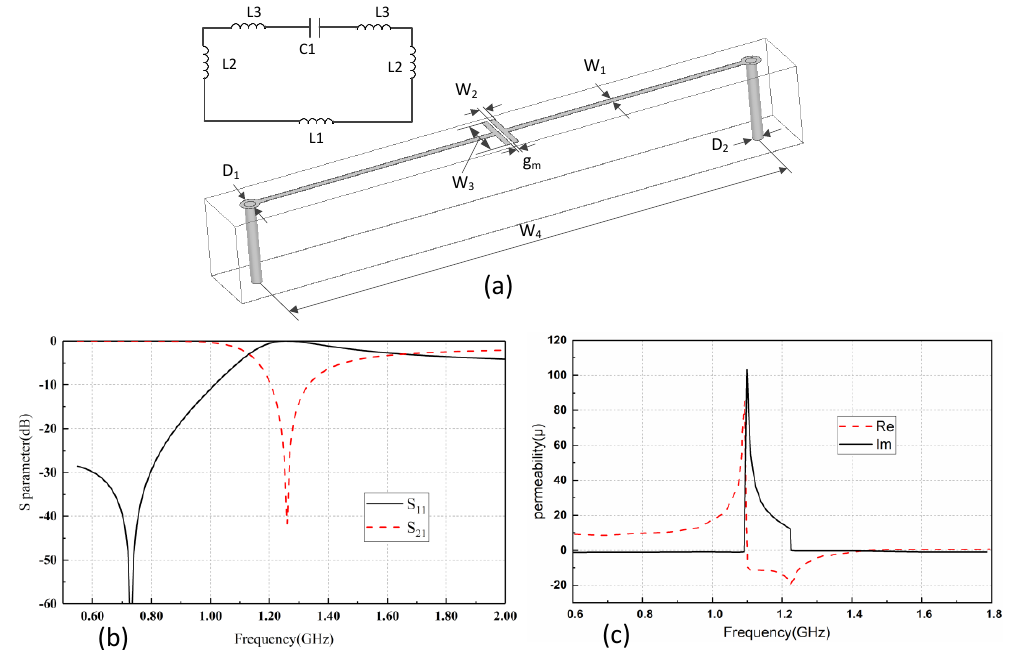
Figure 4. The ( a ) geometry of the Substrate Integrated Split Ring Resonator (SI-SRR) and its equivalent circuit, ( b ) simulated S parameters of the SI-SRR, and ( c ) calculated effective permeability of the